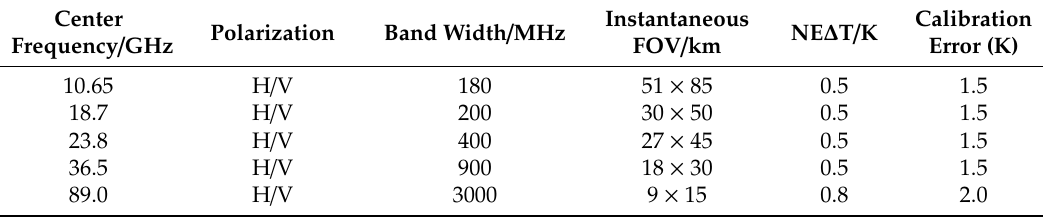
Table 1. MWRI channel